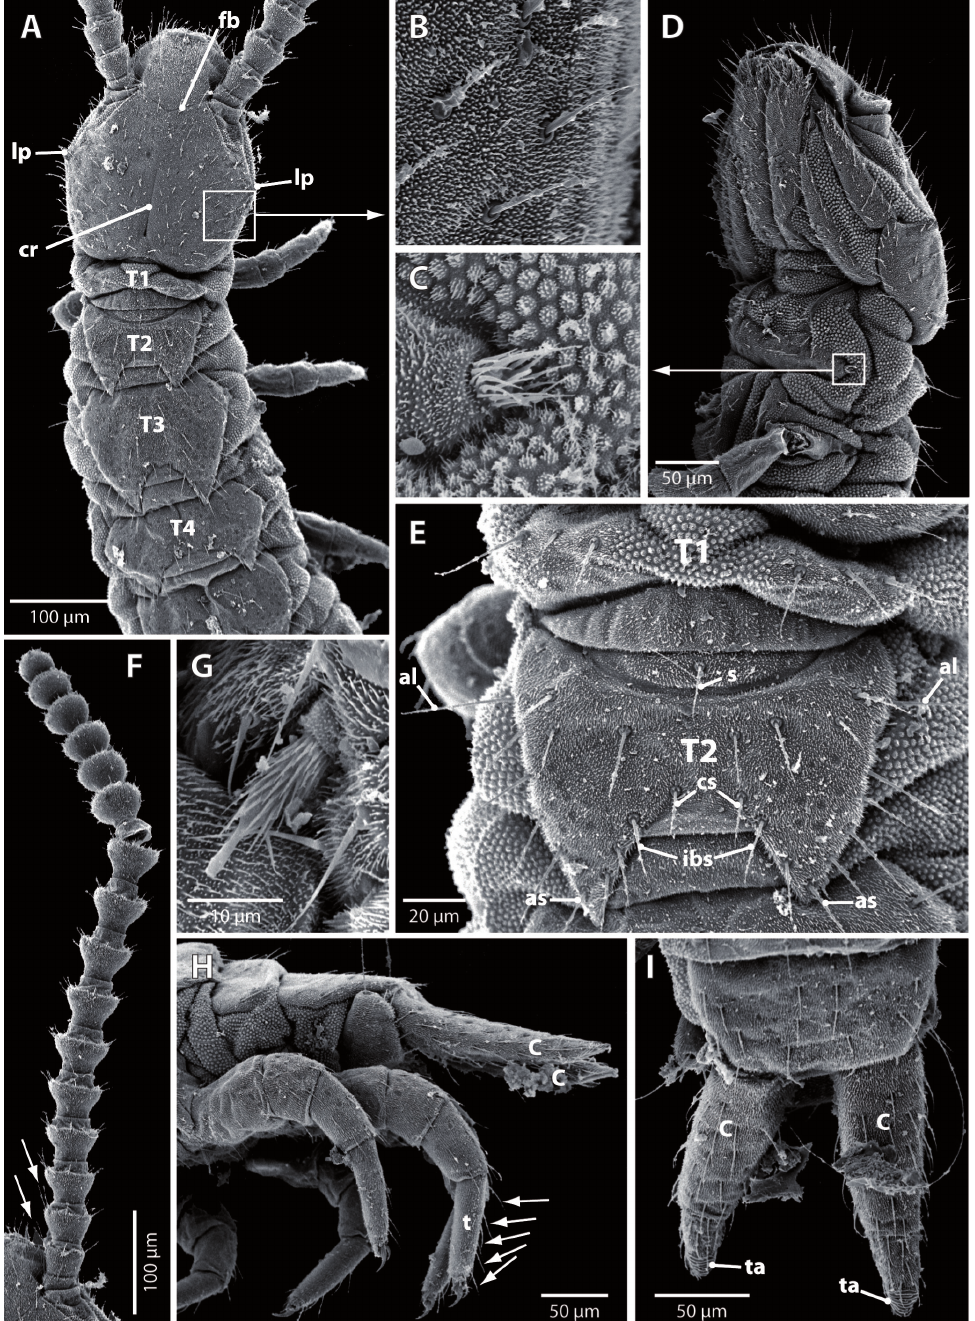
Fig. 5. Symphylella malagassa sp. nov., holotype (dorsal views) and paratype (ventral and lateral views). A . Head and first 4 tergites ( T1, T2, T3, T4 ), dorsal view. Cr , central rod; fb , frontal branches; lp, lateral protuberances of the head. B . Detail of the surface of the head. C . Detail of the first leg. D . Head and first 2 pairs of legs, ventro-lateral view. E . Detail of first ( T1 ) and second ( T2 ) tergites. Al , anterolateral setae; as , apical setae; cs , central setae of the posterolateral setae; ibs , inner basal setae of the posteromarginal setae; s , seta between first and second tergites. F . Right antenna. Arrows , longer inner setae of second and third segments. G . Stylus of the leg 11. H . Posterior part of the trunk, last pairs of legs and cerci ( C ), lateral view. Arrows , longer setae of the tarsus ( t ) of last left leg. I . Last tergite and cerci ( C ), dorsal view. Ta , terminal